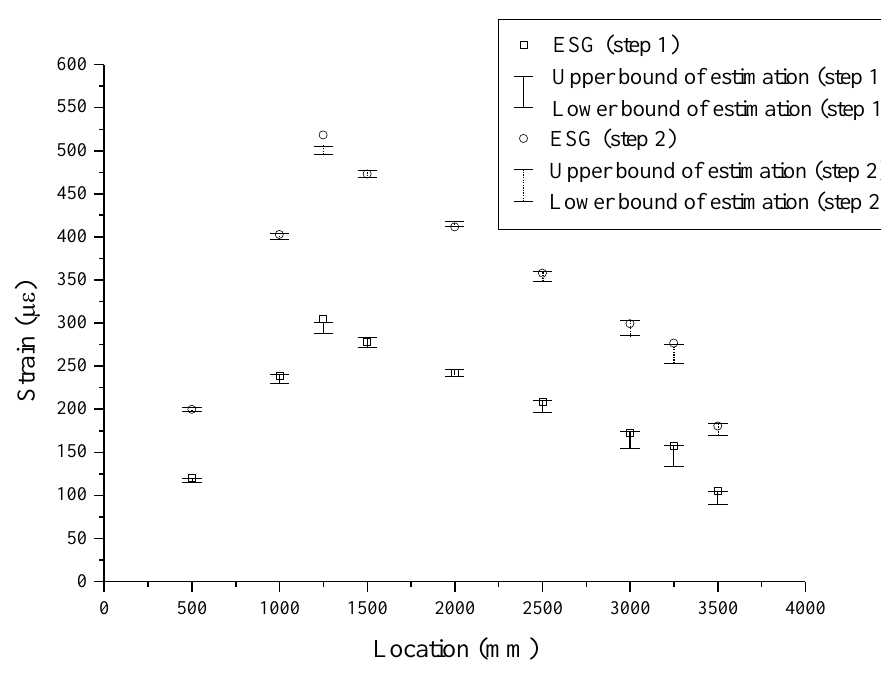
Figure 6. Comparison between estimated and measured strains.